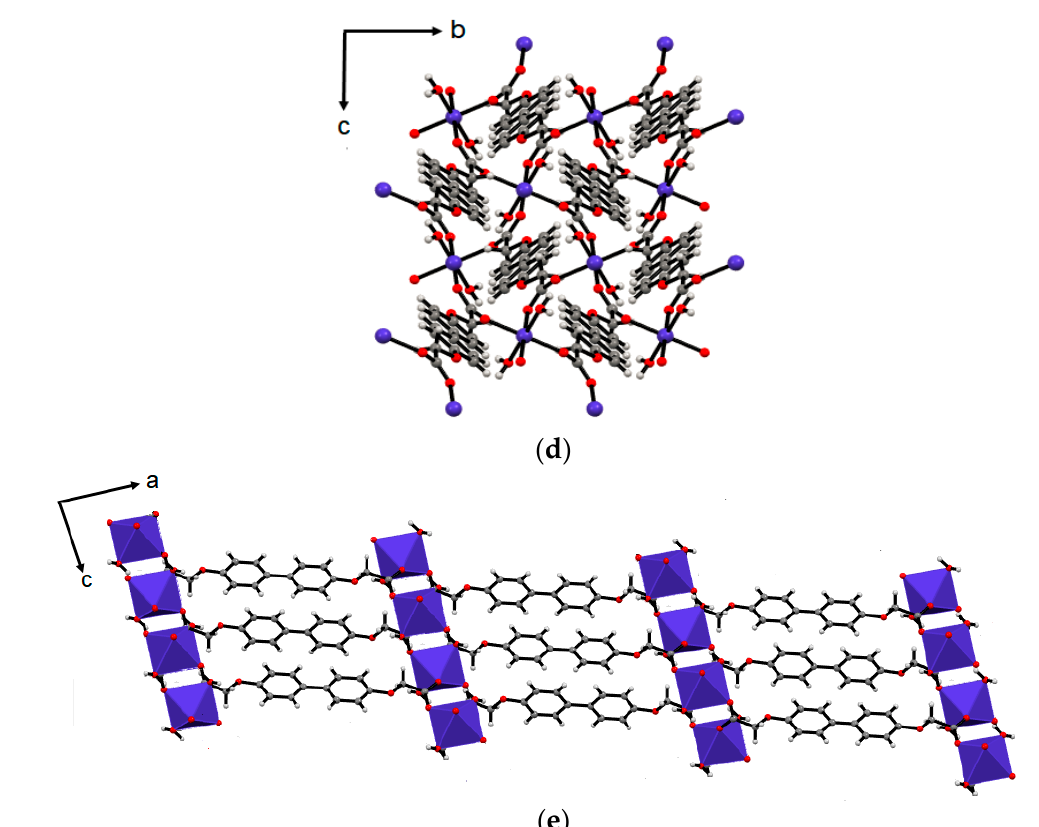
Figure 1. Structural fragments of 1 . ( a ) Coordination environment of Co center; 50% probability level ellipsoids are drawn; ( b ) coordination polyhedron of Co atom; ( c ) ligand arrangement around metal center; ( d ) 2D layer motif in view along the a axis; and ( e ) 3D metal-organic network with polyhedral representation of Co atoms; view along the b axis. Symmetry codes: (a) x, − y + 0.5, z + 0.5; (b) –x, y − 0.5, − z + 0.5; (c) –x, − z + 1, − z + 1; and (d) − x + 2, − y + 1, − z + 1.